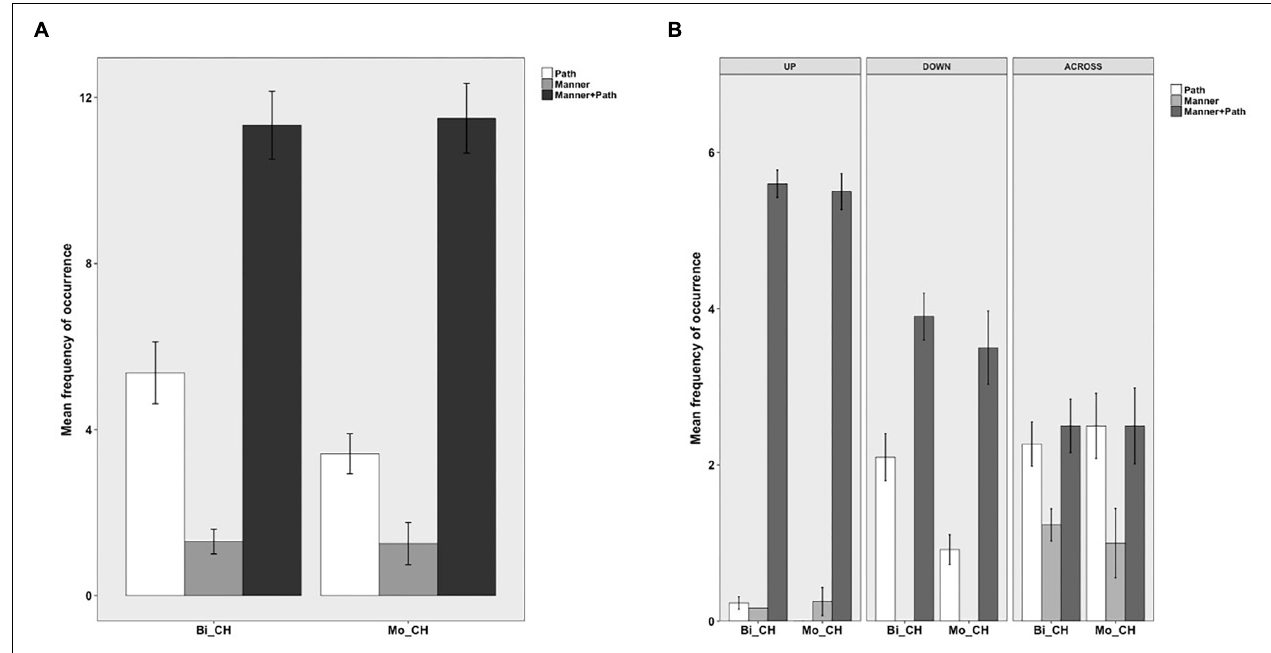
FIGURE 2 | Information in the verb locus in